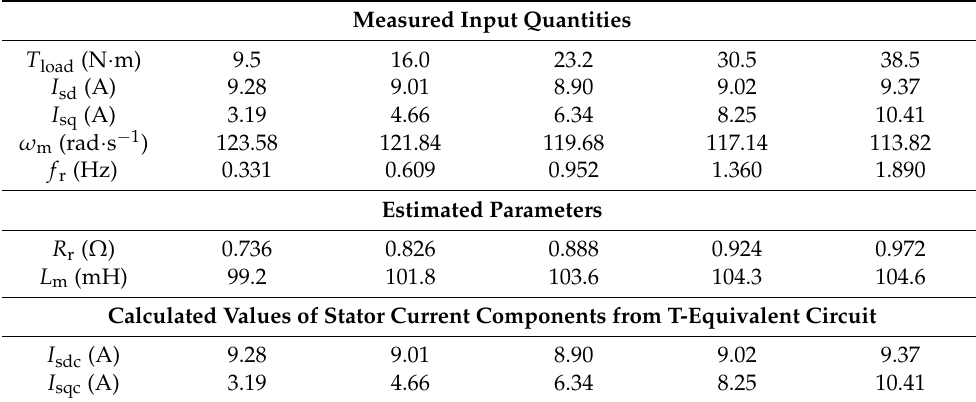
Table 3. Measurement at f s = 20 Hz ( ω s = 125.66 rad · s − 1 ) and V sq = 130 V.